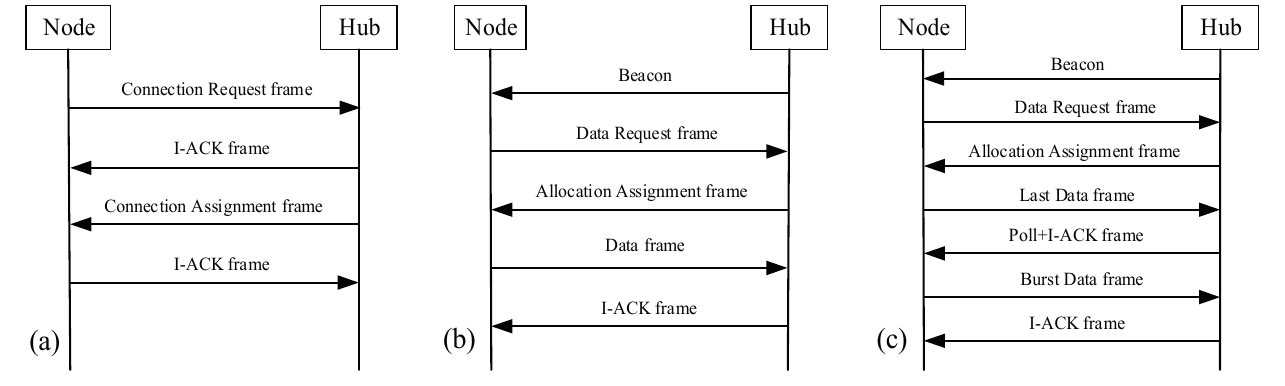
Figure 9. ( a ) Node connection procedure; ( b ) Periodic traffic transfer model; ( c ) Burst traffic transfer model.